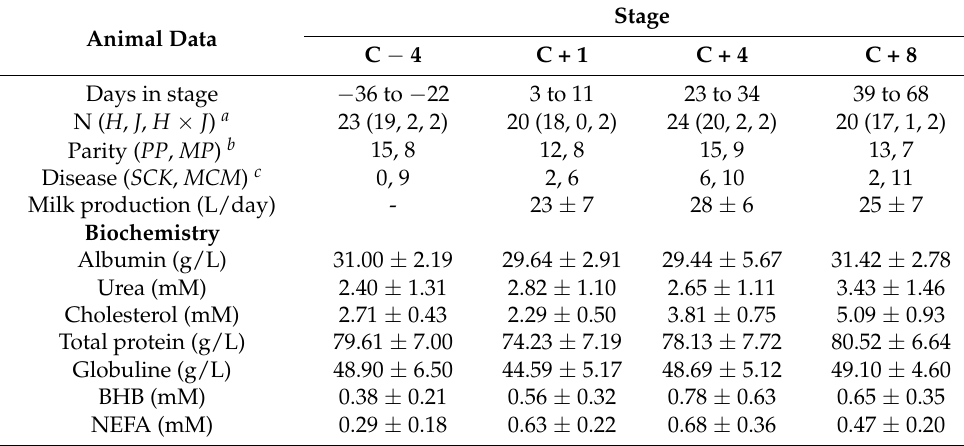
Figure 2. PCA score plot obtained from 1 H NMR spectral data for all serum samples. The plot was colored based on breed ( a ), parity ( b ), or using a continuous coloring scheme which varies as a function of the transition period day relative to calving ( c ). Table 1. Animal and blood biochemistry data for cows within each stage identified through multi- variate analysis of 1 H NMR data.